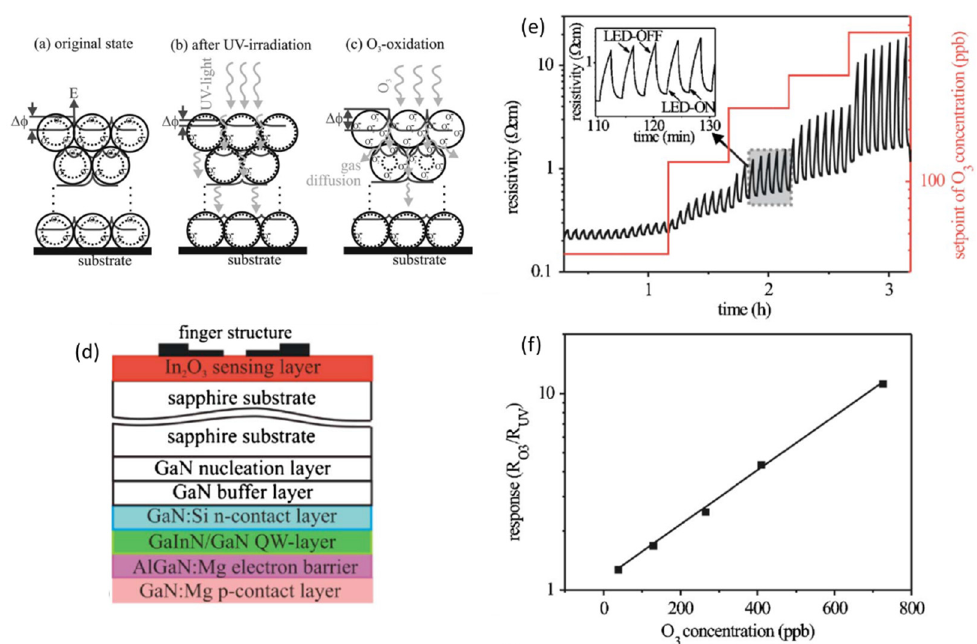
Figure 5. ( a – c ) Schematic of the steps followed during photoactivated sensing: the initially adsorbed oxygen species are forced to desorb from the sensor surface by UV illumination, releasing their trapped electrons into the n-type sensor (In 2 O 3 ) and, thus, reducing the energy barrier between grains switching into a low-resistivity state. Exposure to an oxidizing analyte (O 3 ) recovers the initial high-resistance state by trapping, again, surface free electrons and increasing the energy barrier between grains. Reproduced with permission from [24]. Copyright 2007, American Institute of Physics. ( d ) Schematic of a photoactivated In 2 O 3 sensor with integrated UV LED emitter ( e , f ) response signal and sensitivity of a photoactivated In 2 O 3 sensor for ozone detection with pulsed UV operation. Reproduced with permission from [28]. Copyright 2007, American Institute of Physics.